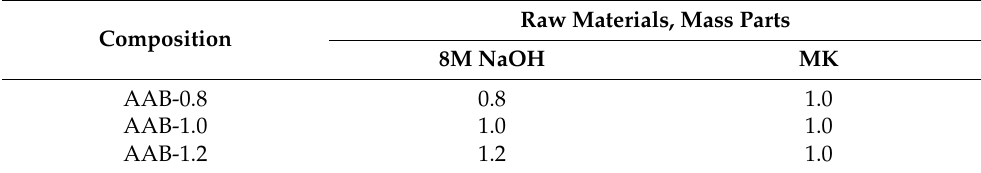
Table 2. Composition of the studied alkali-activated binder.